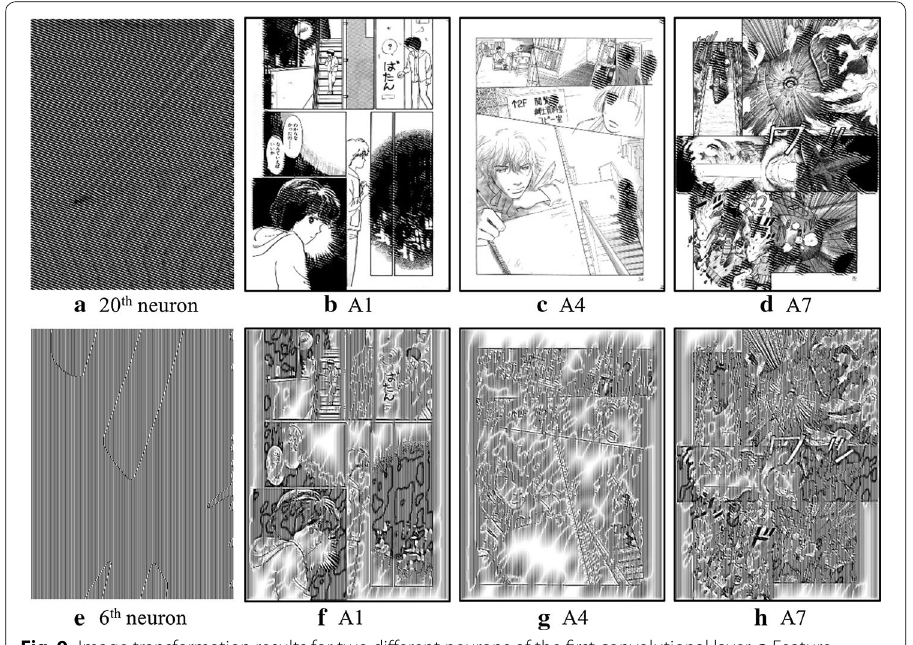
Fig. 9 Image transformation results for two different neurons of the first convolutional layer. a Feature visualization of 20th neuron, b – d transformed images using 20th neuron in classes A1, A4 and A7. e Feature visualization of 6th neuron, f – h transformed images using 6th neuron in classes A1, A4 and